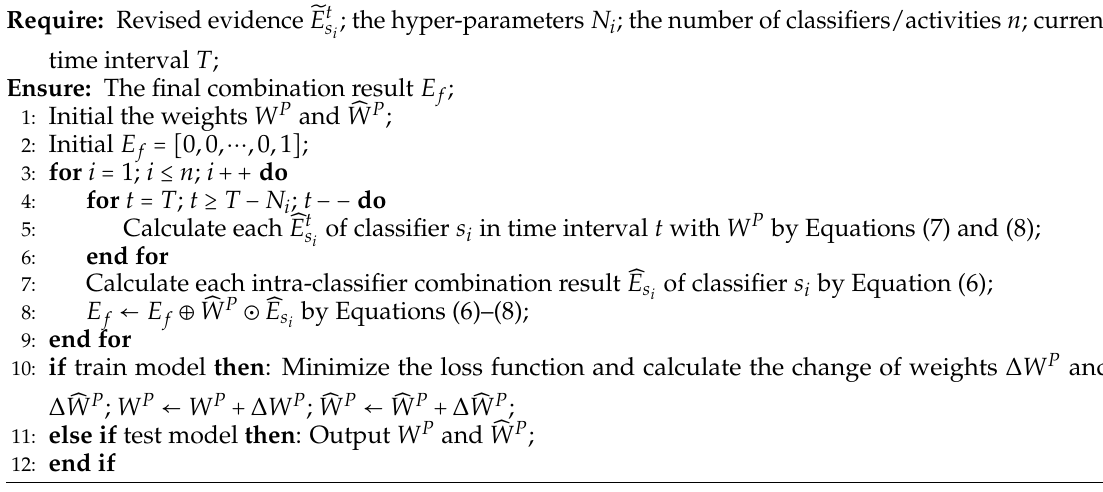
Algorithm 1 Time series evidence combination